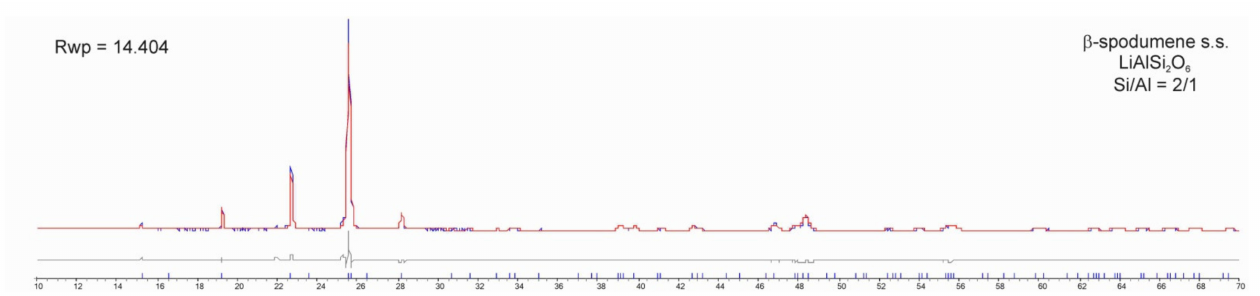
Figure A9. Variation of the average cell parameters (Å) for each nominal chemical composition ( x value) in the three mineral solid solutions: β -eucryptite, β - spodumene, and α -quartz.